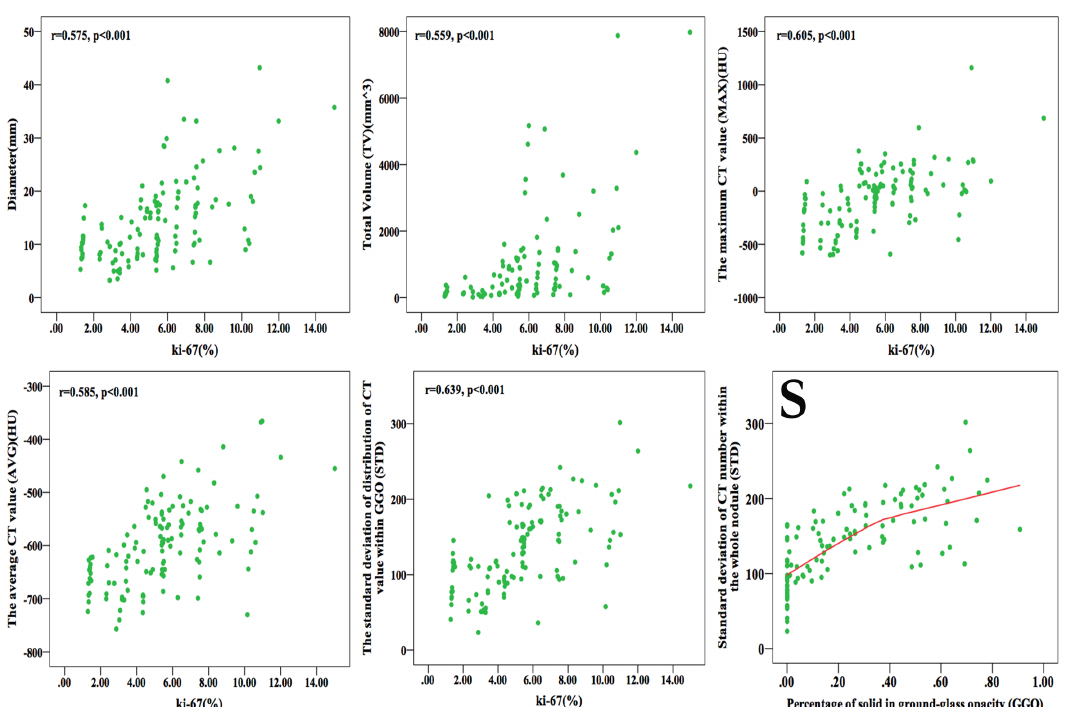
Fig 6. Graphs showing the correlation between Ki-67 labeling index (LI) and diameter, total volume (TV), the maximum CT value (MAX), average CT value (AVG), standard deviation of CT value within the whole nodule (STD) respectively, and correlation between STD and percentage of solid component in ground-glass opacity (GGO) nodule. (r means correlative coefficient) Diameter, TV, MAX, AVG and STD were positive correlation with Ki- 67. Graph (S) shows that in the heterogeneous model of GGO, STD increase along with solid component growing in it instead of decrease after solid-part more than 50% of nodule.